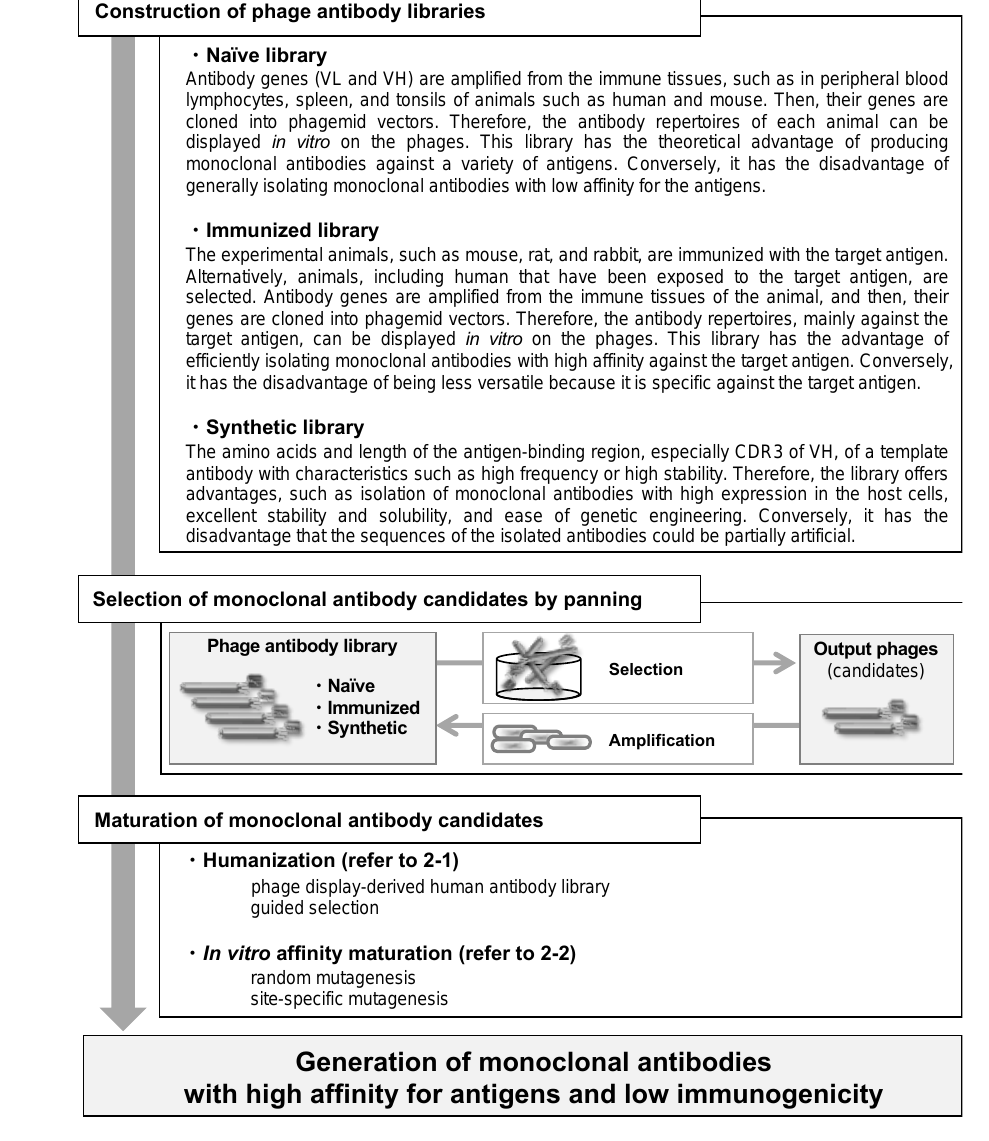
Figure 2. Flow chart outlining the sequence of events from construction of phage antibody libraries to generation of monoclonal antibodies with high affinity for antigens and low immunogenicity.